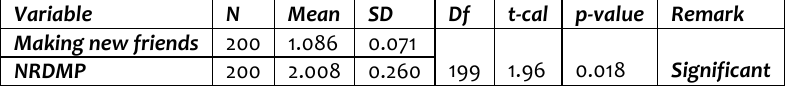
Table 4: t-test summary on making new friends for numerical reasoning